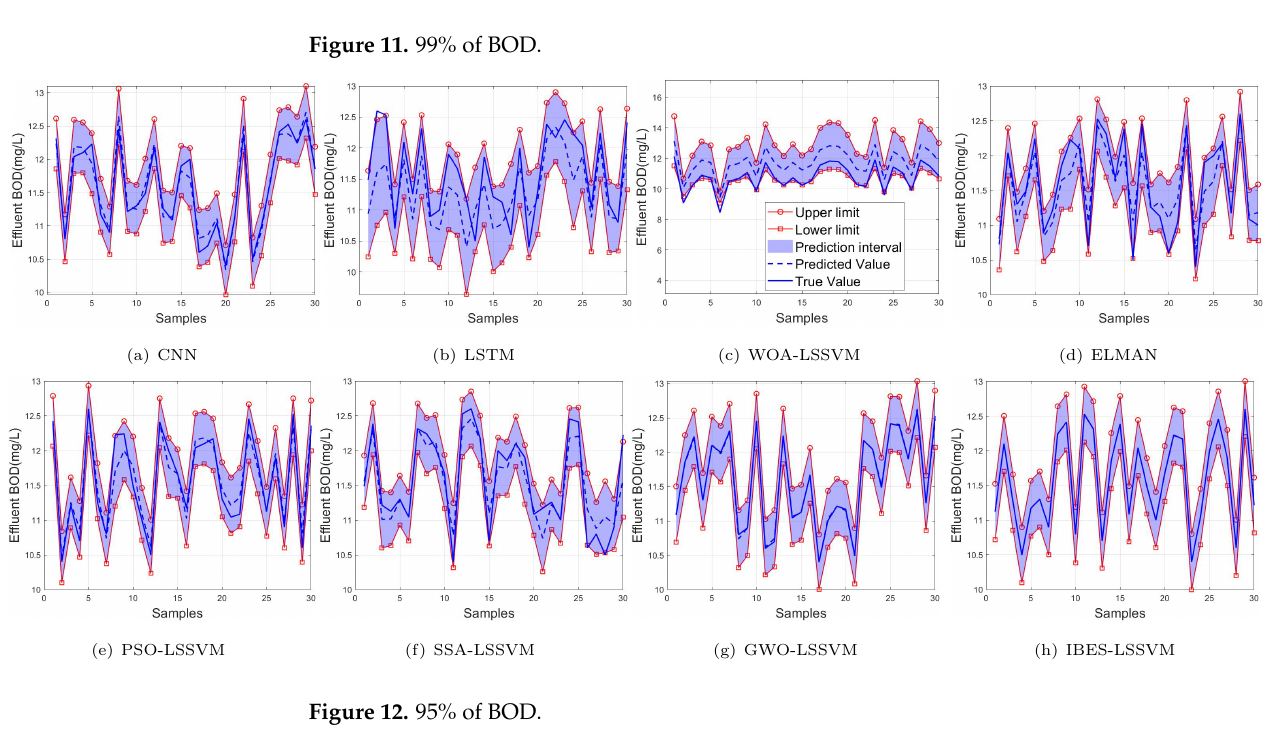
Figure 12. 95% of